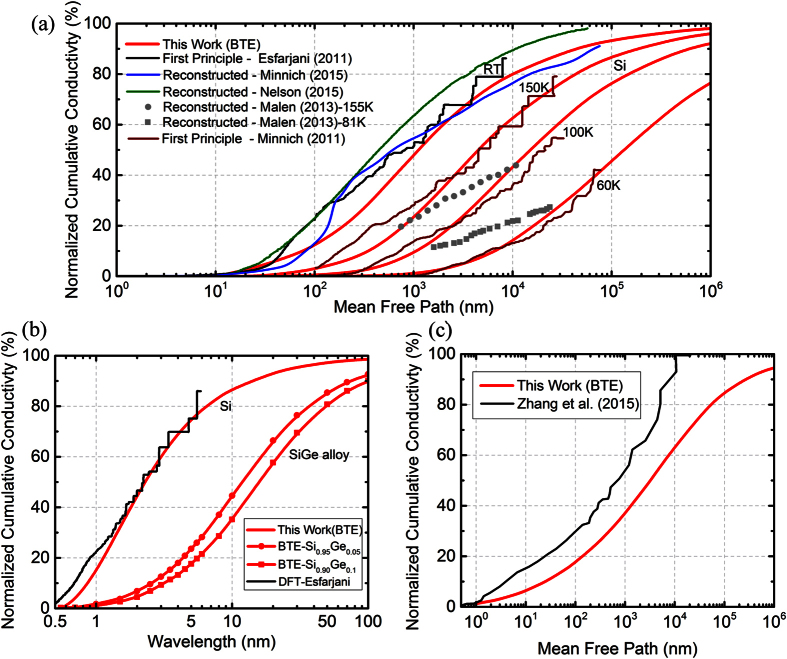
(a) Comparisons between mean-free-path heat spectrum (normalized cumulative conductivity) for bulk Si from our calculations, first principle approaches, and reconstruction from experiments3233343536 (b) Calculated wavelength heat spectrum for bulk Si and SiGe alloy, and (c) Calculated mean-free-path heat spectrum for Si0.9Ge0.1 nanowire and the reconstructed spectrum using Ziman’s formula for η = 0.1 nm35.